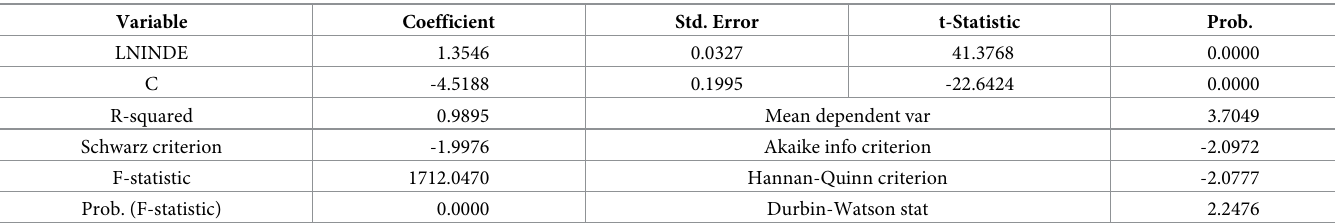
Table 5. Internal R&D E-G two-step regression results.